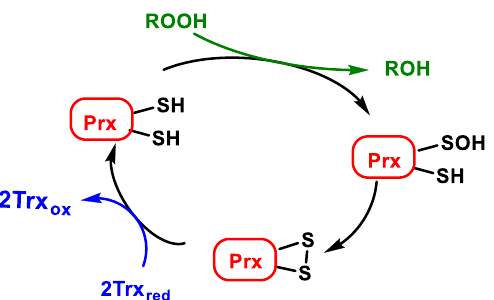
Figure 18. Catalytic cycle of atypical peroxiredoxins (atypical 2-Cys-Prx).